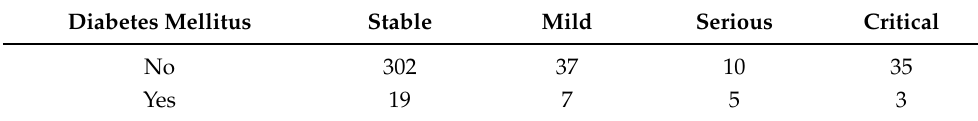
Table 3. Contingency table for exposure diabetes mellitues to Severity of the case.